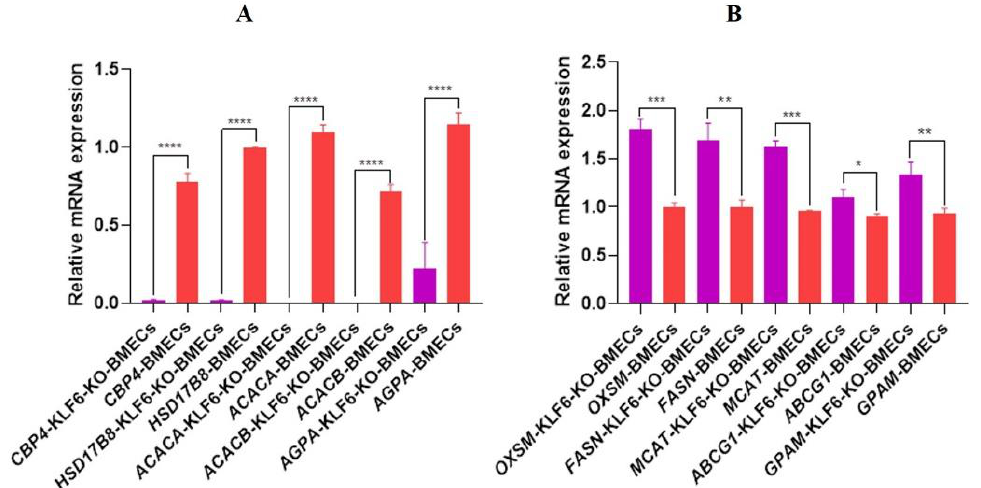
Figure 16. ( A , B ); mRNA expression of marker genes associated with lipogenesis in the KLF6 -KO- BMECs and normal BMECs. * p < 0.05, ** p < 0.01, *** p < 0.001, **** p <